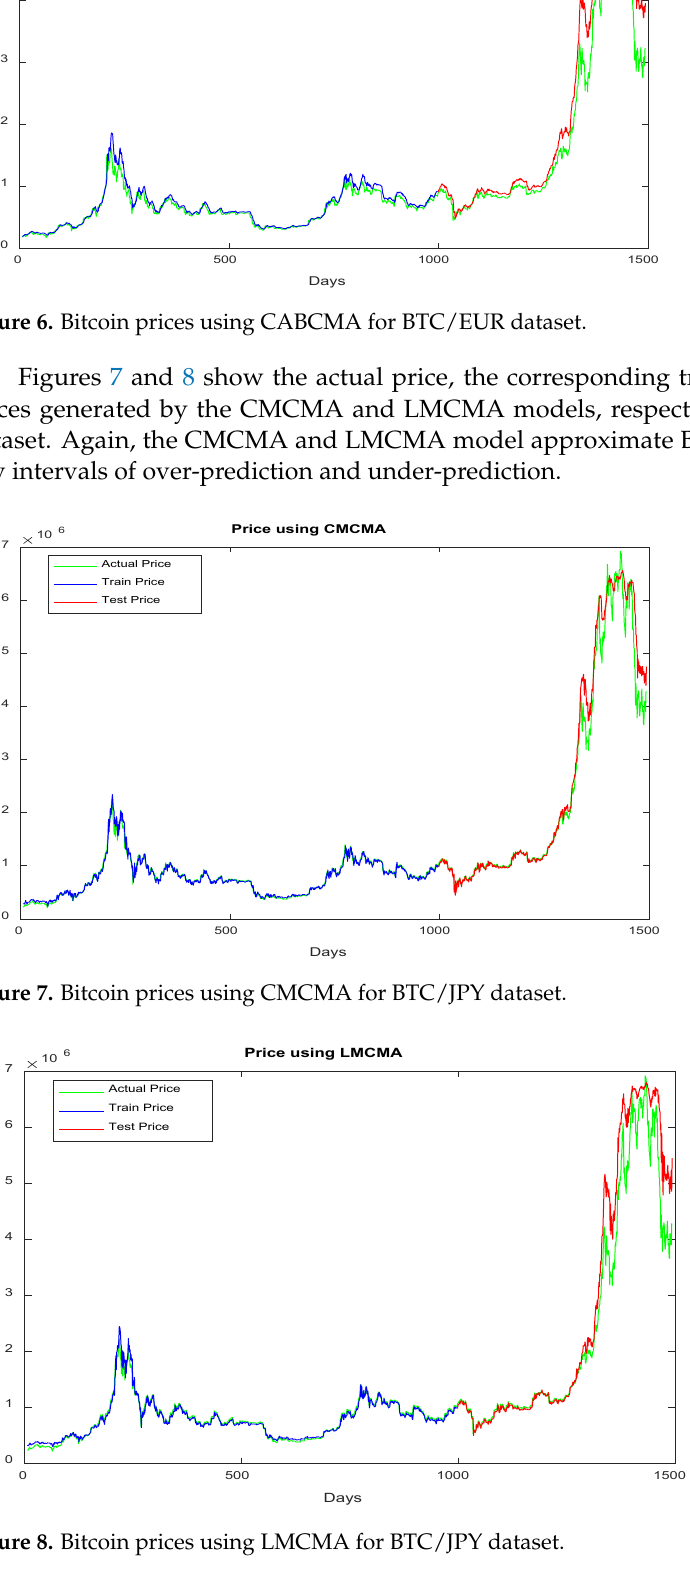
Figure 8. Bitcoin prices using LMCMA for BTC/JPY dataset. In addition, to determine the learning capability of each model, the RMSE fitness value was plotted against the number of iterations for all models under study using the three datasets. Figures 9–11 show the RMSE plots for the BTC/USD, BTC/EUR, and BTC/JPY datasets, respectively. It is observed that the fitness value is better minimized by the MCMA models than by the other models.